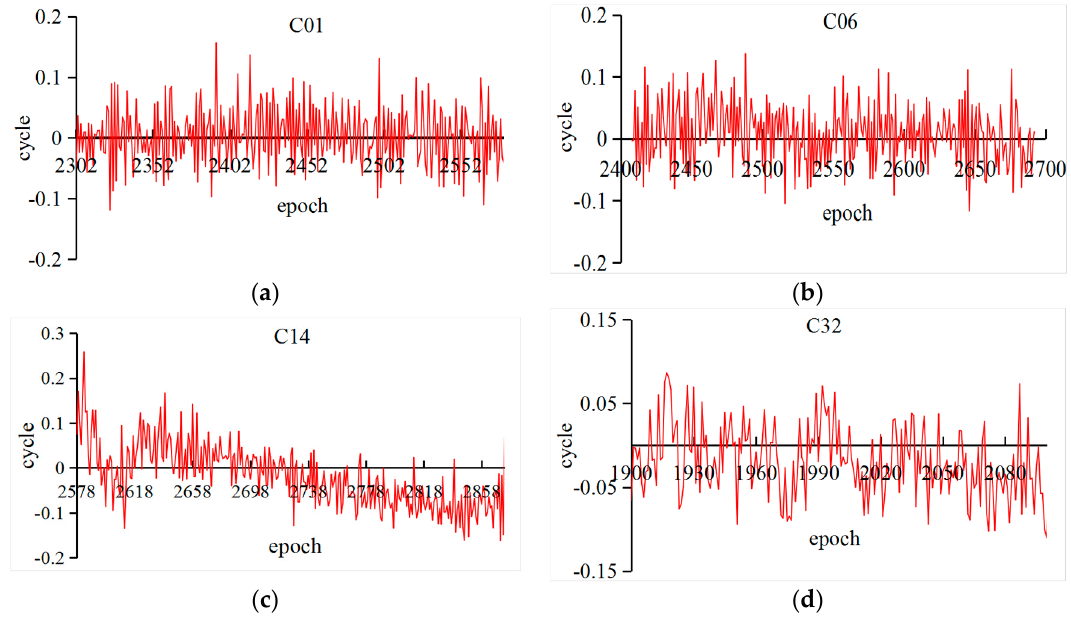
Figure 3. Time series of the fractional parts of B2 (C01, C06, C14) and B3 (C32) observations on DOY 183 based on LHA1 (( a ) C01 (BDS_GEO); ( b ) C06 (BDS_IGSO); ( c ) C14 (BDS_MEO); and ( d ) C32 (BDS-3)).